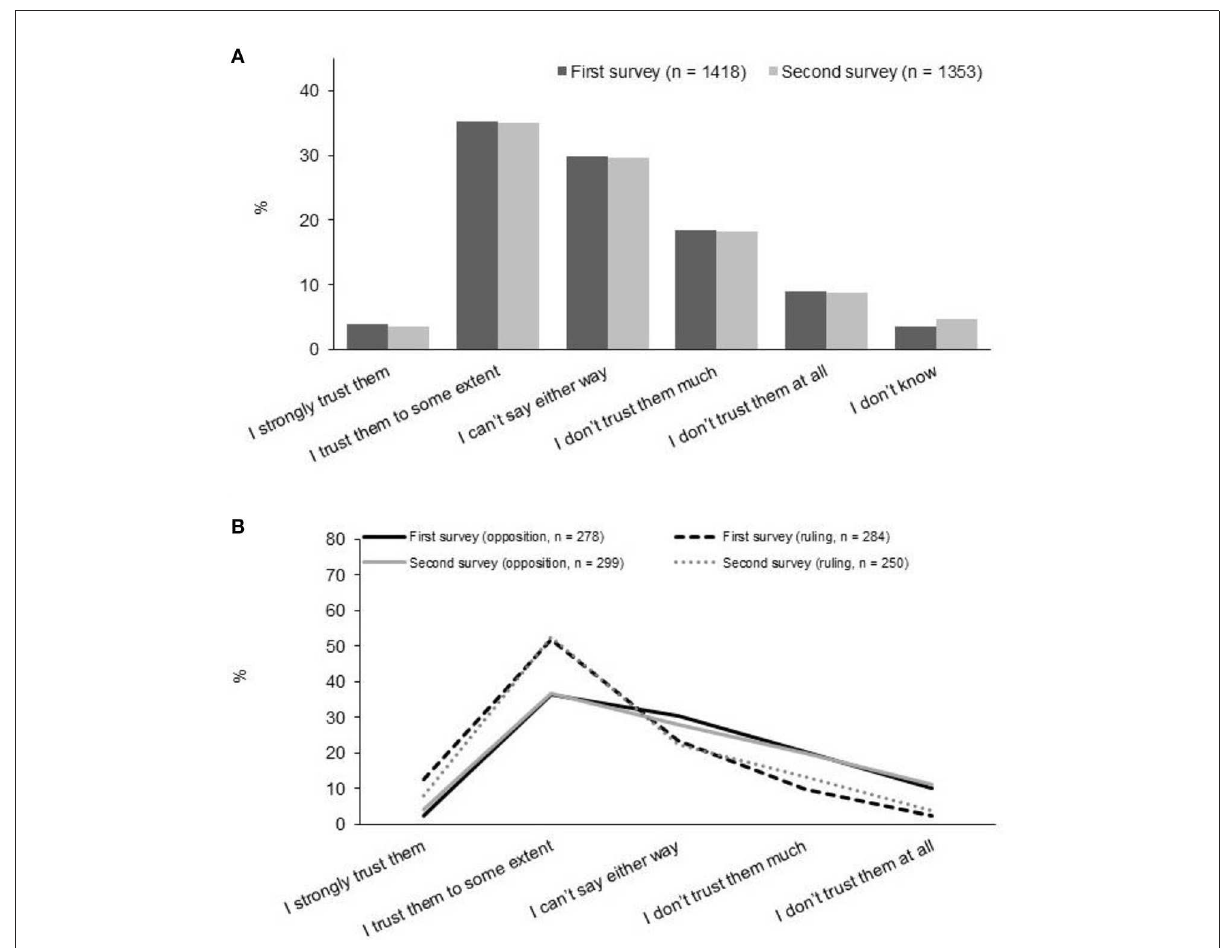
FIGURE2 (A) Level of trust in COVID-19 experts and (B) level of trust based on support for different political parties. Note: “I don’t know” responses were not